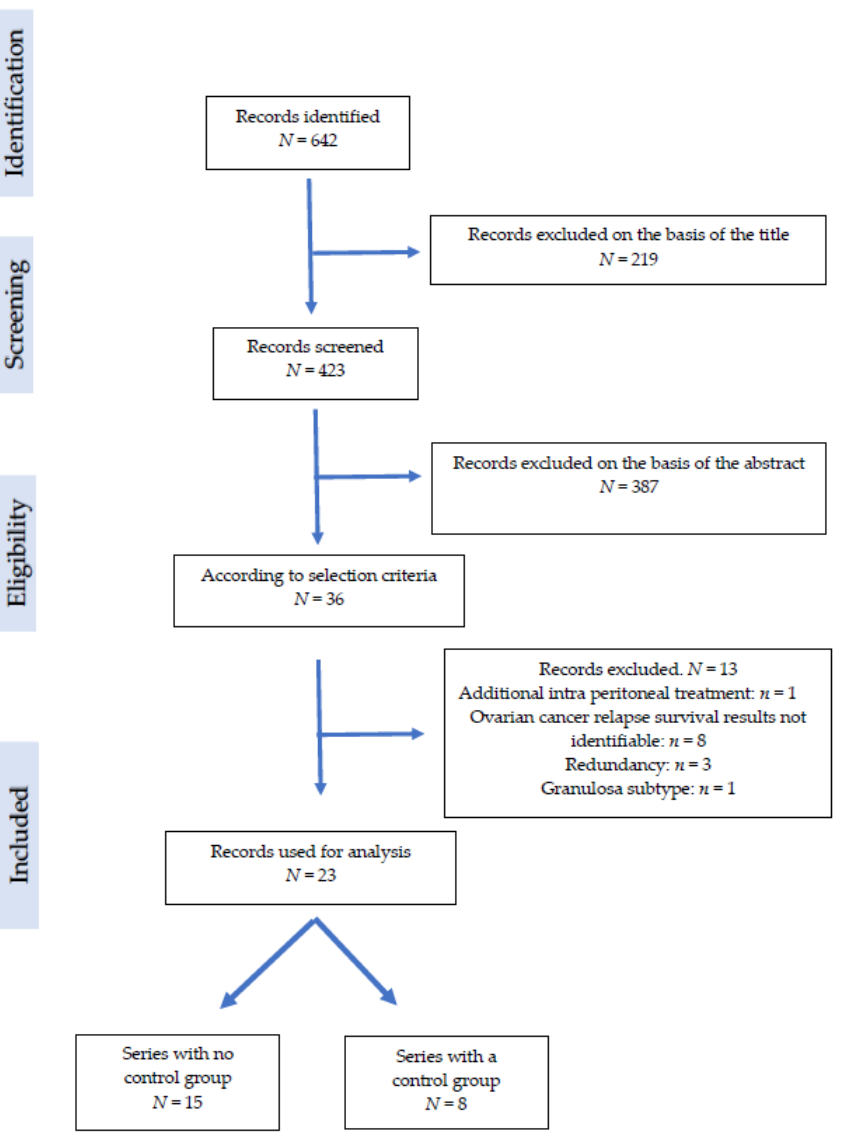
Figure 1. PRISMA flowchart depicting the number of identified articles, those screened and the final number included in the systematic review.